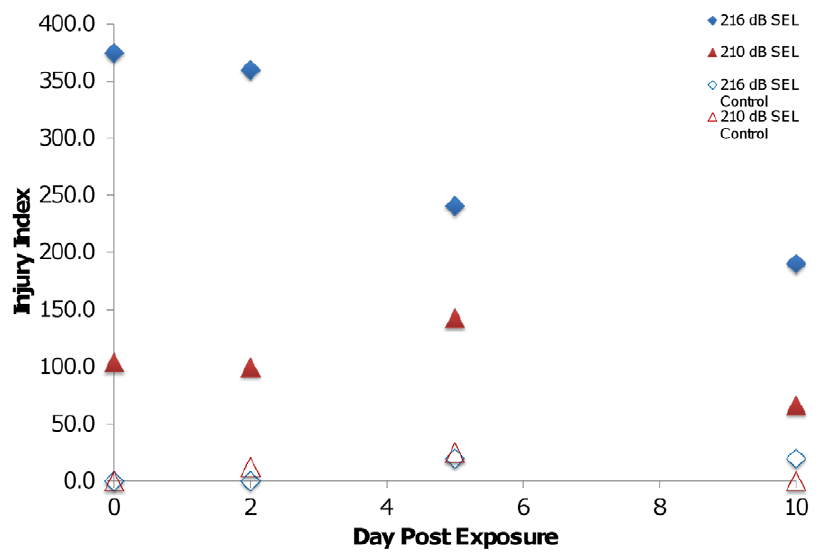
Figure 4. Injury index values for Chinook salmon. The injury index values for Exposure 1 and 2 to which Chinook salmon were exposed. There was a significant decrease in RWI scores from day 2 to day 5 in Exposure 1 fish (solid blue diamonds), suggesting that this is when healing is beginning to occur. There were no differences between days 5 and 10, implying that after initial healing of more serious injuries occurs, it then may take longer for minor injuries such as hematomas to heal. There was no significant difference between days 0 through 10 for fish in Exposure 2 (solid red triangles) and each day was not significantly different than controls (open blue diamond for Exposure 1 and open red triangle for Exposure 2).